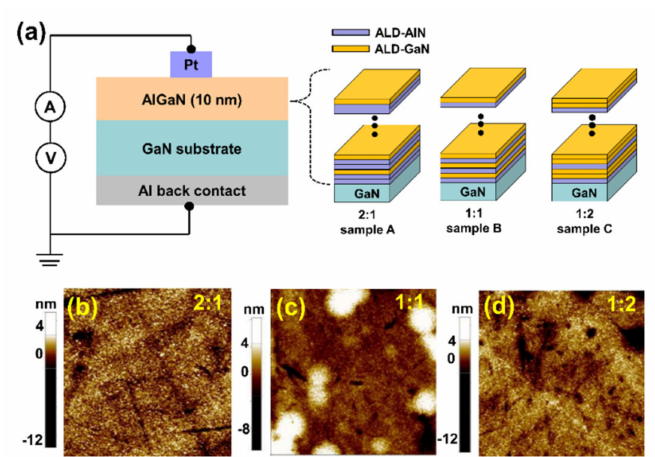
Figure1. ( a )SchematiclayerstructuresofAlGaN / GaNdevicesandpreparedAlGaNlayerswithdi ff erent pulse ratios. ( b – d ) The atomic force microscopy (AFM) surface images scanned over 2 µ m × 2 µ m areas.